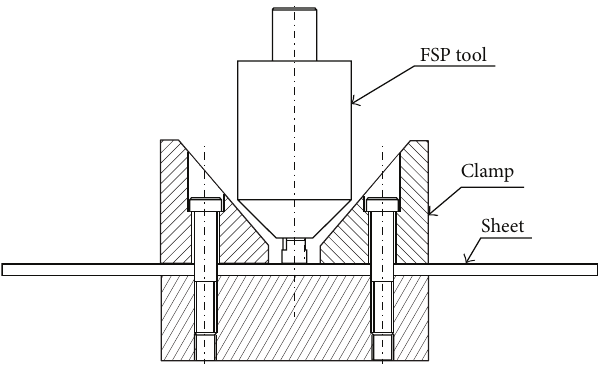
Figure 17: Device to process larger